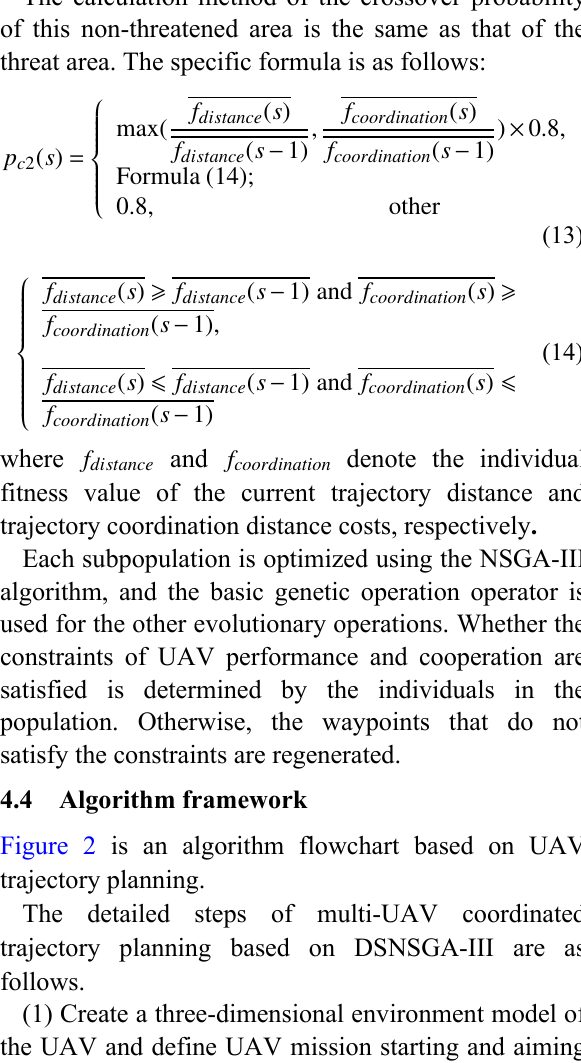
Figure 2 is an algorithm flowchart based on UAV trajectory planning.